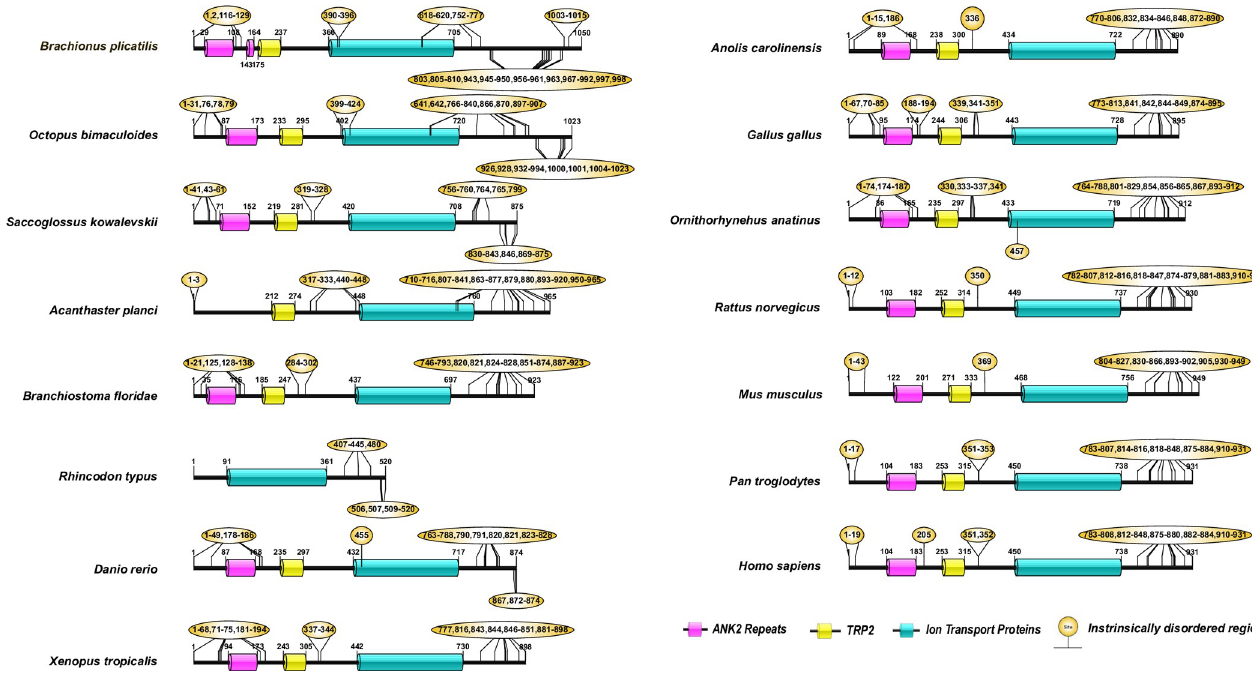
Fig 6. Domain organization in TRPC6, TRPC3, and TRPC7 sequences. The ankyrin repeats in the sequences are represented as a pink rectangle; similarly, the yellow rectangle represents TRP domains, and teal represents the ion transport domain, and the yellow bubbles represent the intrinsically disordered